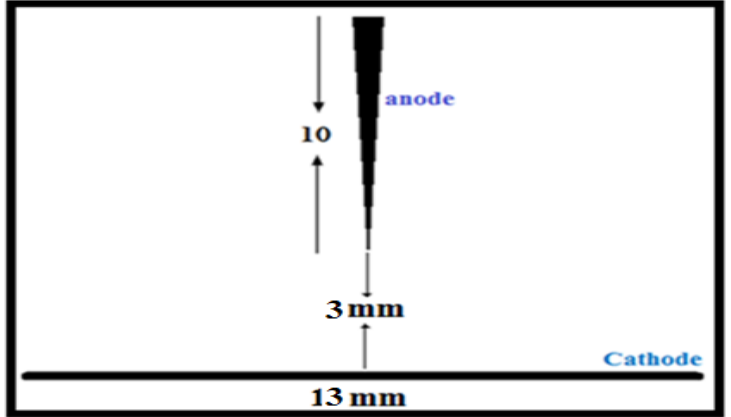
Fig.1: Longitudinal cross section of pin - plane